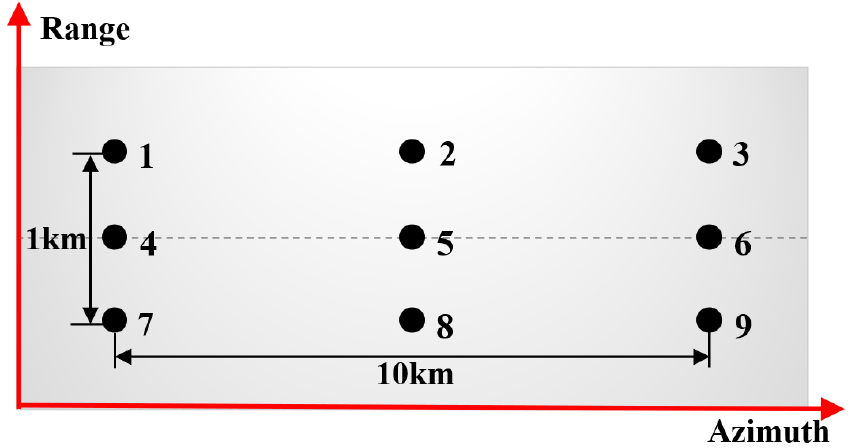
Figure 3. Target distribution for simulations.